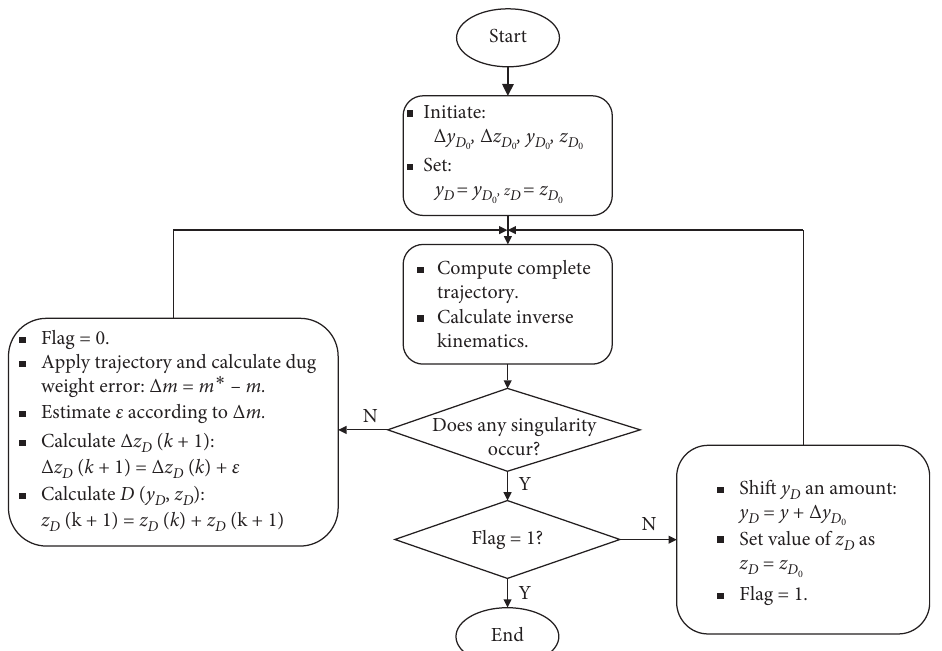
Figure 5: Algorithm of trajectory generation.